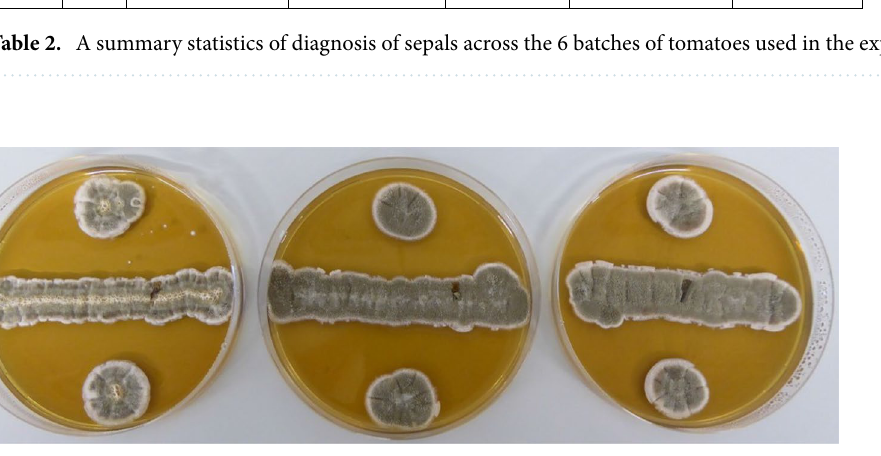
Figure 4. Fungal growth of spores collected from a random tomato calyx on Malt Extract Agar